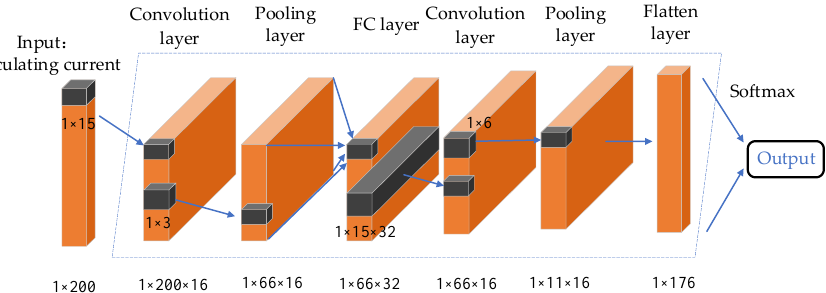
Figure 9. Schematic diagram of fault classification neural network.